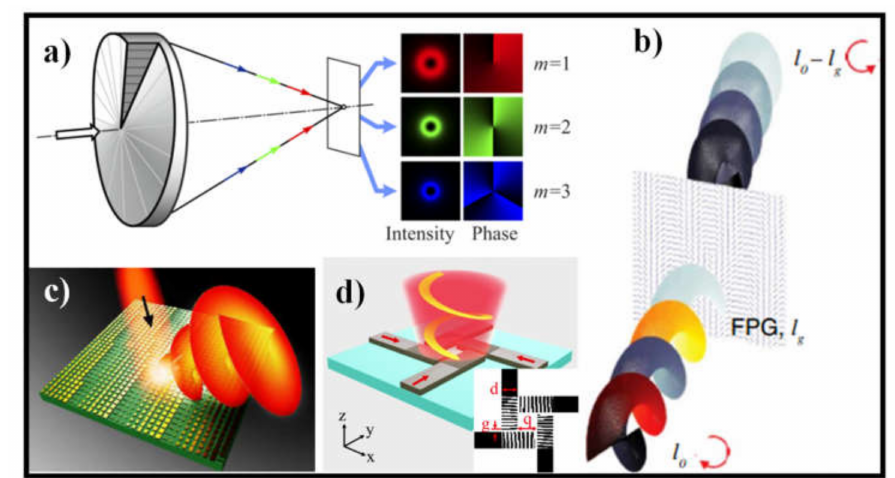
Figure 2. Methods to generate light with OAM: ( a ) Shift in the OAM order by illuminating a 3D element with the laser light of different wavelengths [58]; ( b ) OAM generator via CGH [59]; ( c ) Schematic of the OV beam generator from MS [60]; and ( d ) The schematic illustration of the OV beam generator on the embedded multi-WG